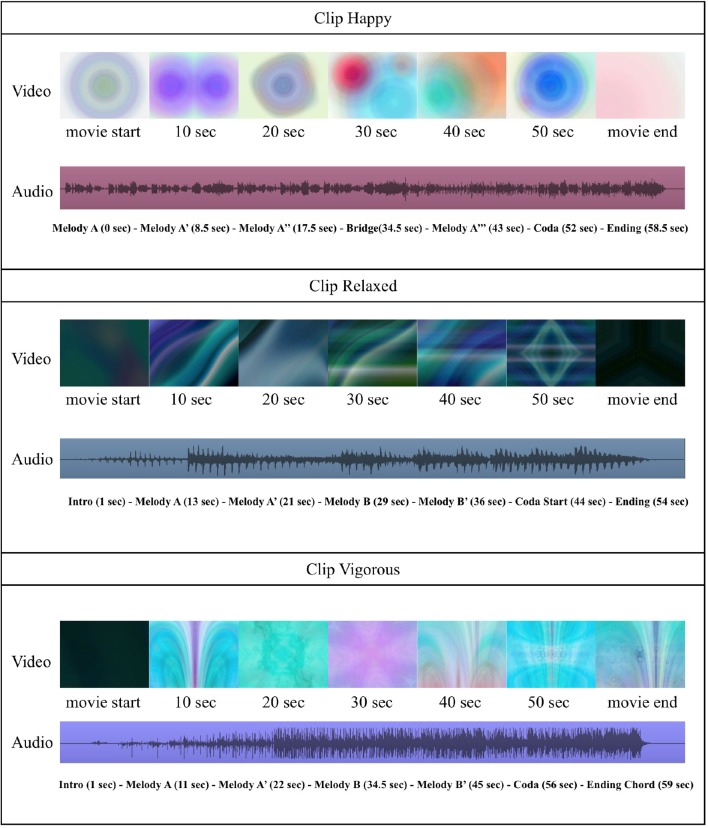
Snapshot information about the visual channel, the auditory channel, and structural variations in the temporal streams of our three positive emotion visual music stimuli.